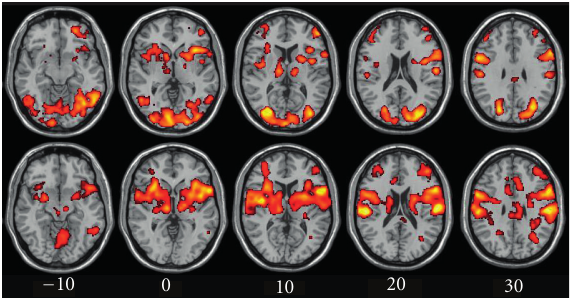
Figure 3: Axial maps showing brain activations for the contrast “shapes-rest” in congenitally blind (upper row) and blindfolded control (lower row) subjects. The color-coded t-maps illustrate voxels showing a task-related increase in activation at P < 0 . 01, FDR-corrected. Right side of the brain is to the right of the image.